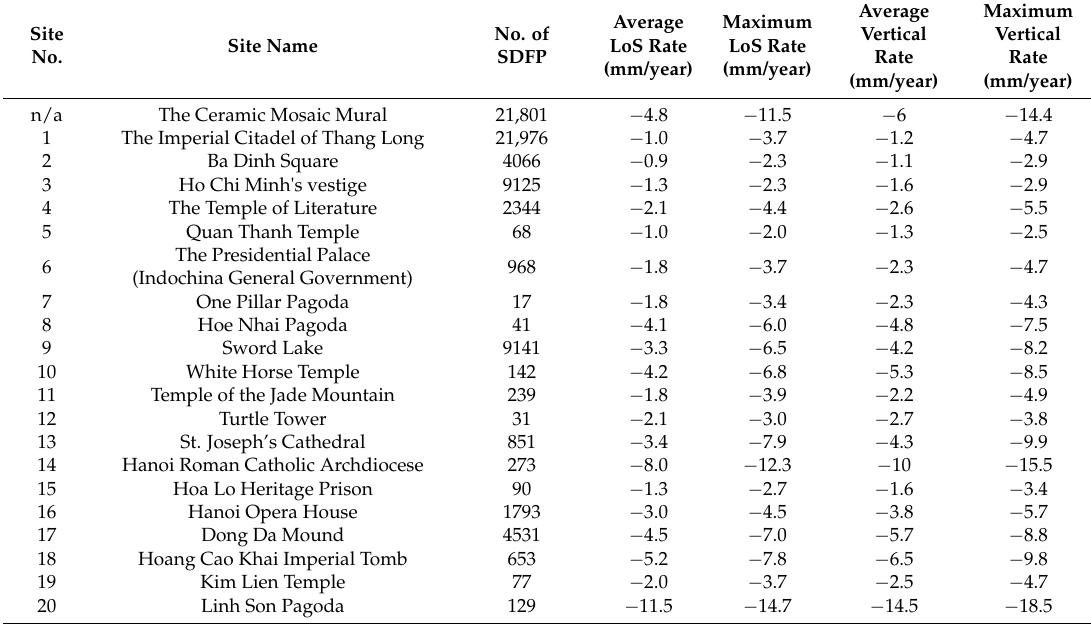
Table A1. Condition assessments of historical monuments and heritage assets in the Historical Centre of Hanoi.